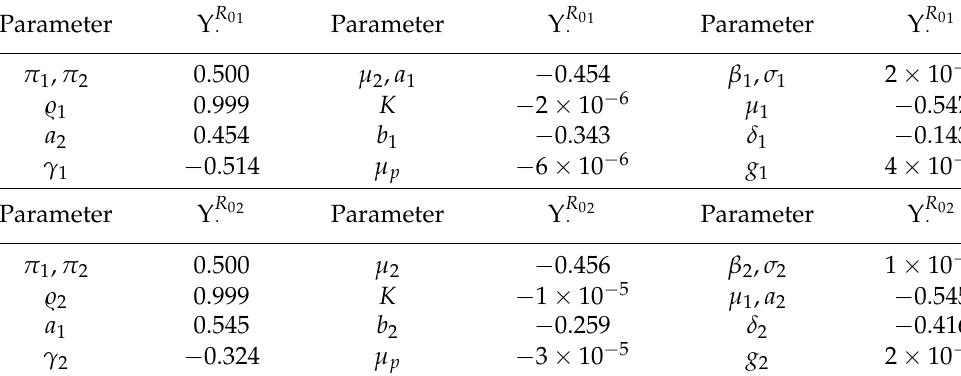
Table 2. Sensitivity of R 01 ( top ) and R 02 ( bottom ), evaluated for the parameter values given in Table 1 with α = 1.